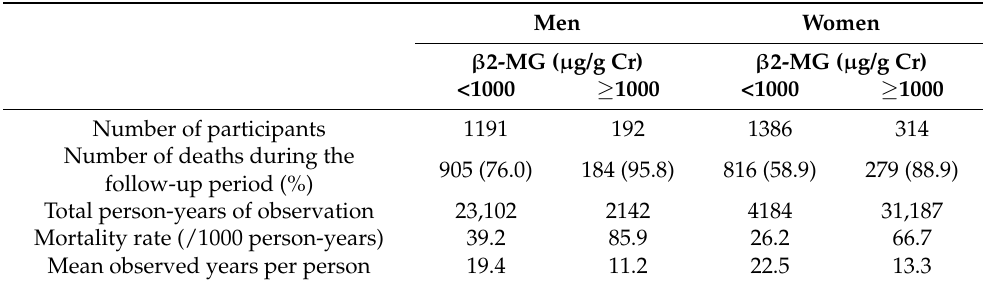
Table 1. Numbers of participants and person-years of follow-up according to the urinary β 2-MG concentration.